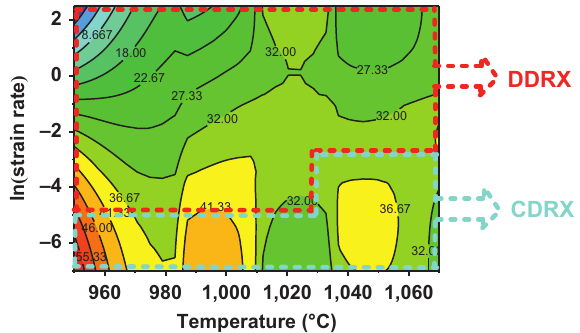
Figure 13: Power dissipation efficiency map for hot deformation process of Ti22Al25Nb alloy at the strain of 0.7. The CDRX domain and DDRX domain are indicated by the blue line and red line,